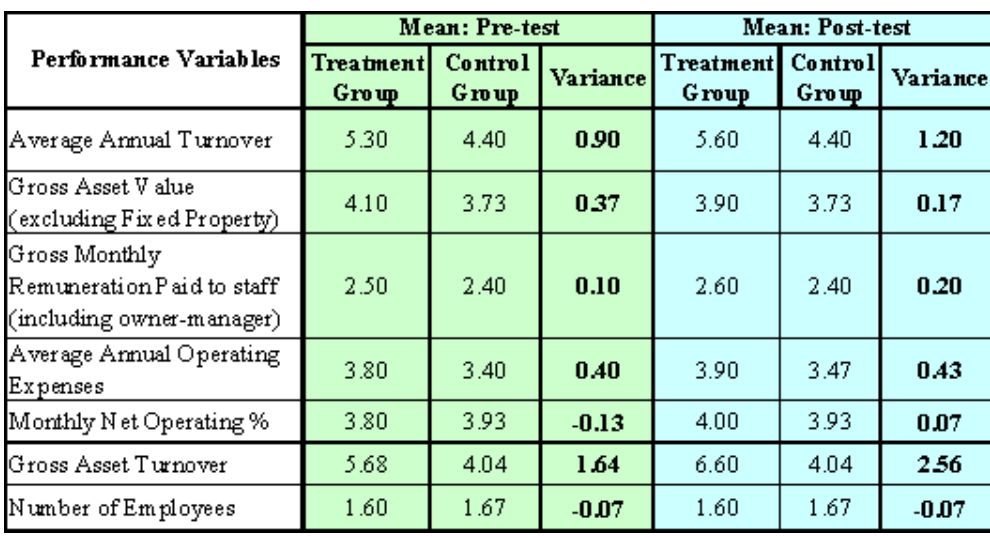
Table 2 Variance of performance variables for the experimental